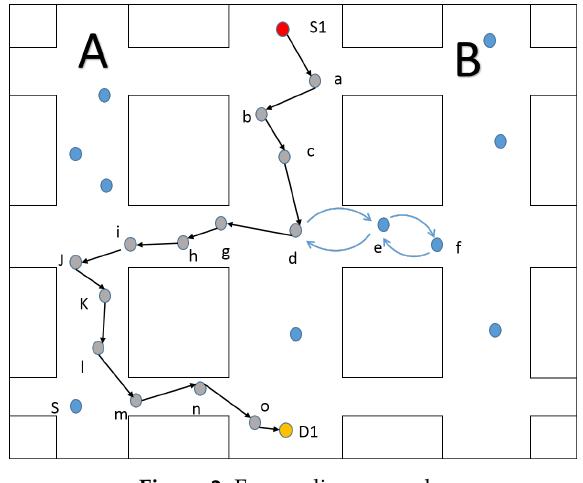
Figure 2. Forwarding